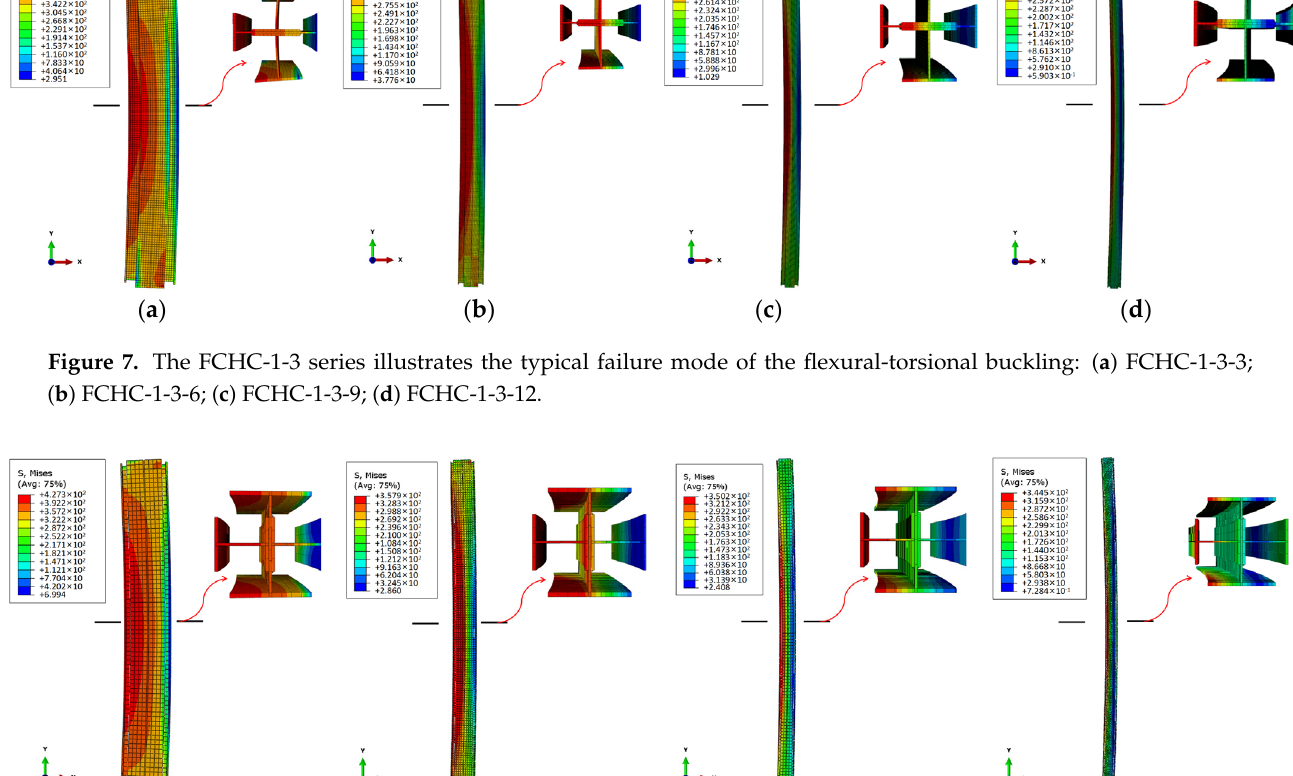
Figure 9. The FCHC-2-3 series illustrates the typical failure mode of the flexural–torsional buckling: ( a ) FCHC-2-3-3; ( b ) FCHC-2-3-6; ( c ) FCHC-2-3-9; ( d ) FCHC-2-3-12.